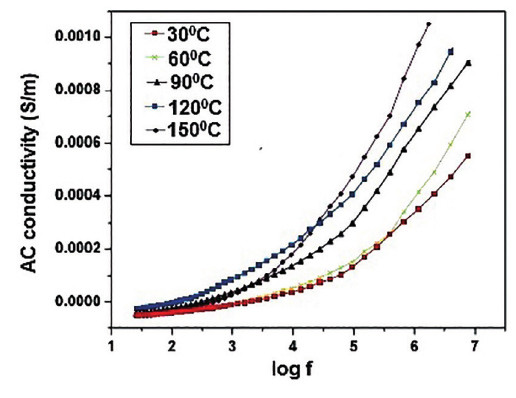
Figure 9: Variation of conductivity with frequency for